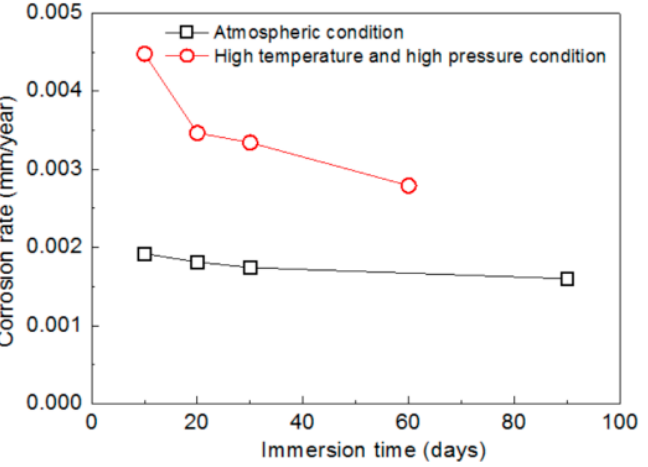
Figure 7. Variations in the corrosion rats of mechanically bonded 316L at different periods of immersion under an atmospheric condition and high temperature and high pressure conditions.